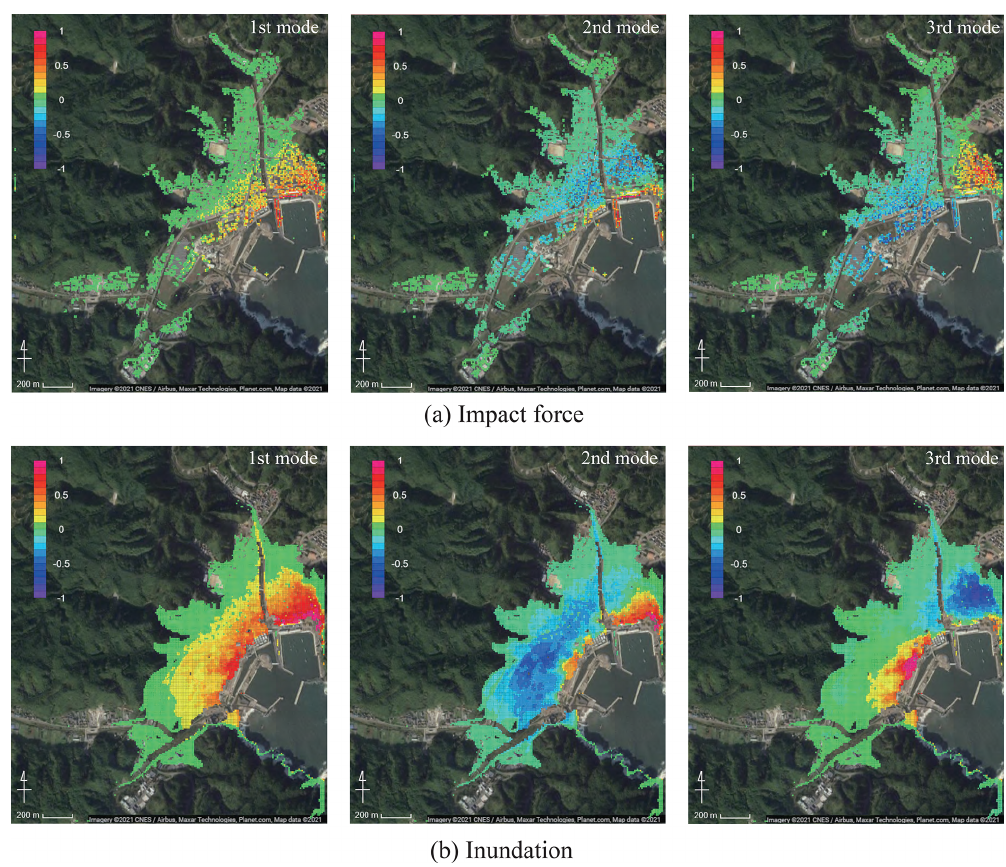
Figure 11. Spatial modes of (a) impact force and (b) inundation depth extracted by POD (© Google Maps).